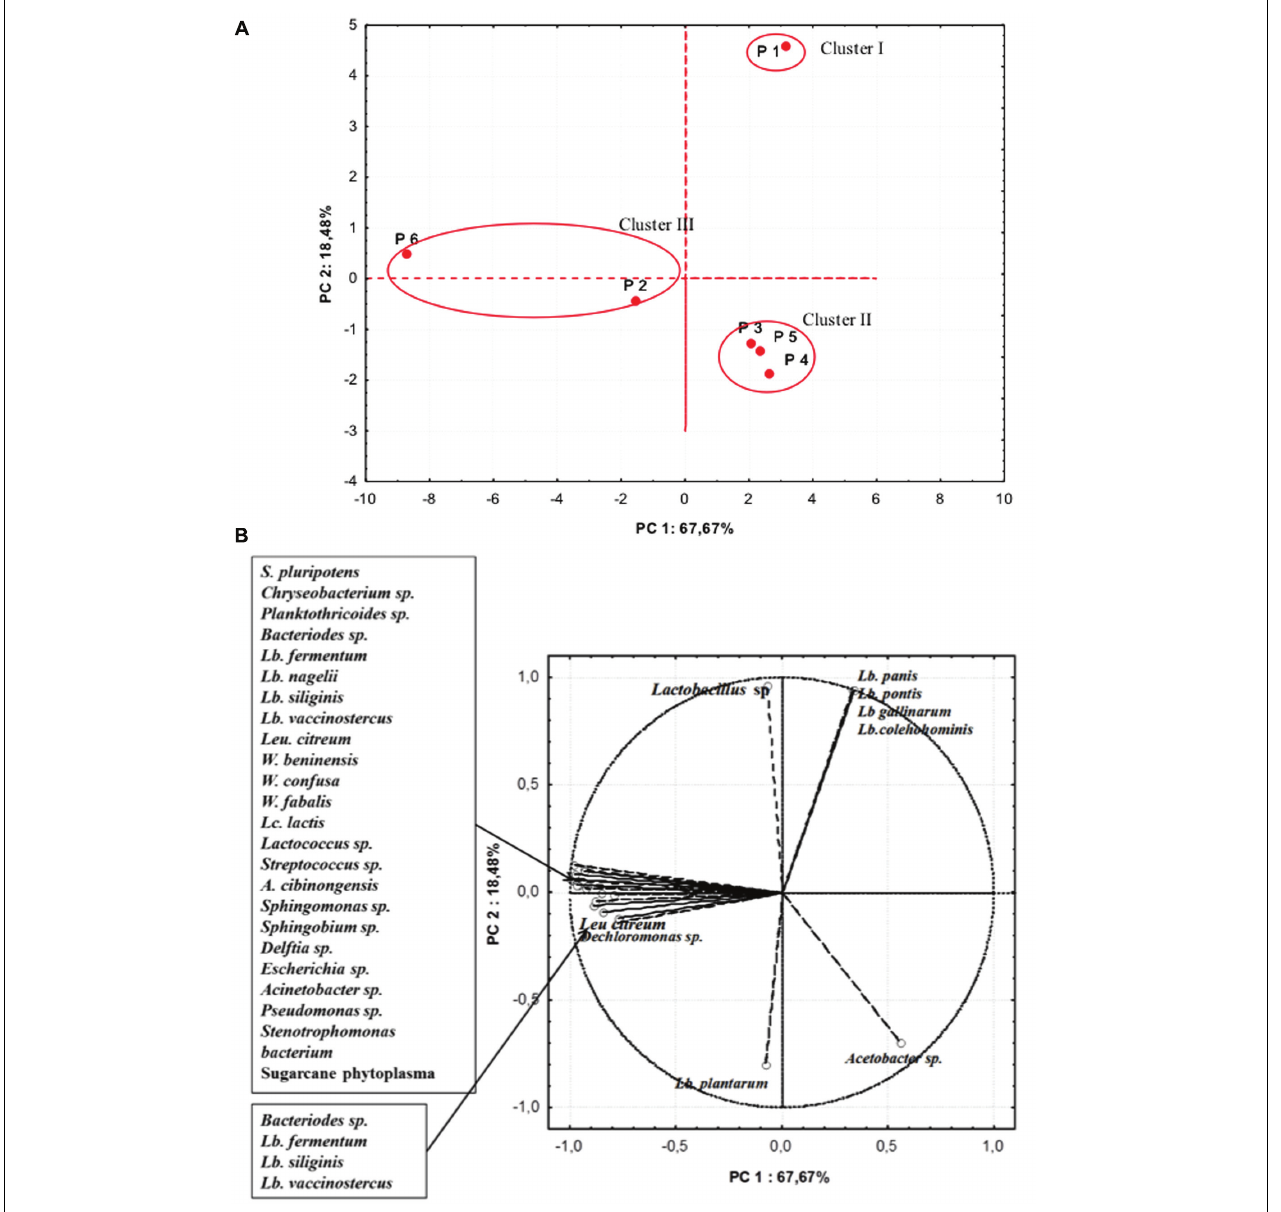
FIGURE 4 | Principal component analysis (PCA) on the relative abundance of bacterial species. (A) Scores (B) Loadings.